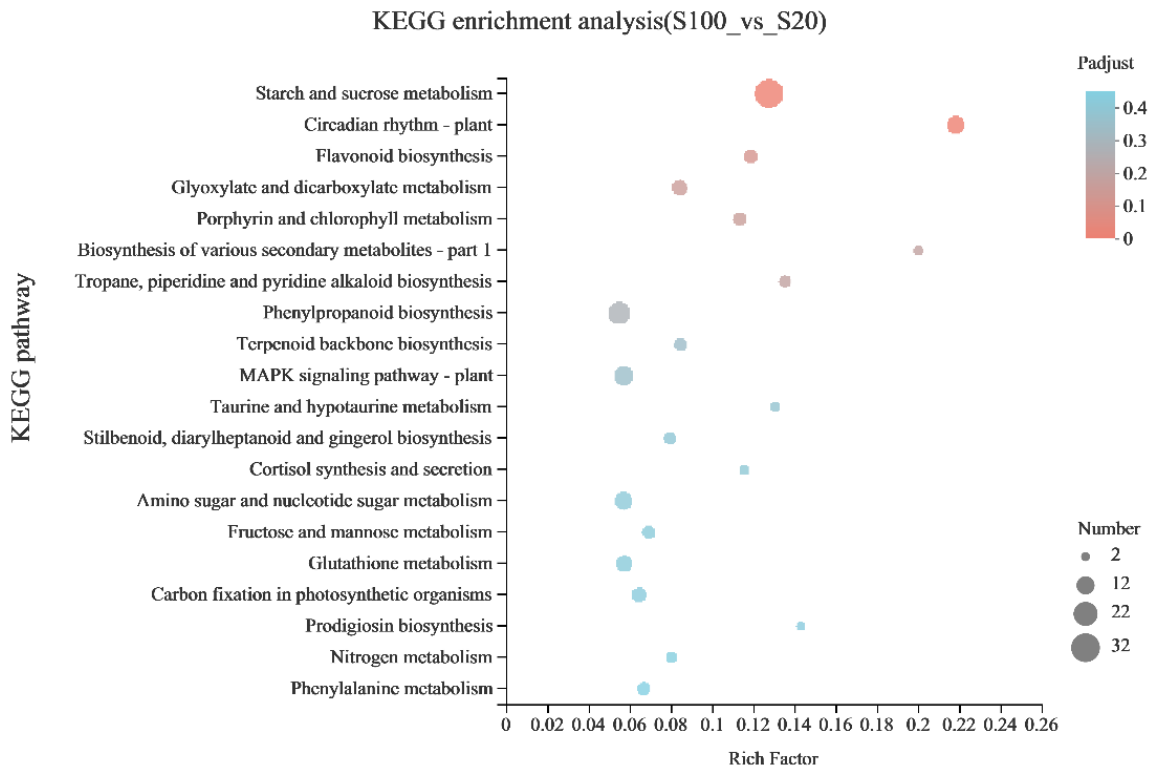
Figure 8. KEGG enrichment analysis. The vertical axis is the pathway entry, and the horizontal axis represents the ratio of the enriched gene number (sample number) to the annotated gene number (background number) in the entry. The greater the rich factor, the greater the degree of enrichment. The size and color of the dots indicate the number of genes in this pathway and the corresponding P-adjust range, respectively. The figure shows the enrichment results of the top 20 pathways of P-adjust from small to large.